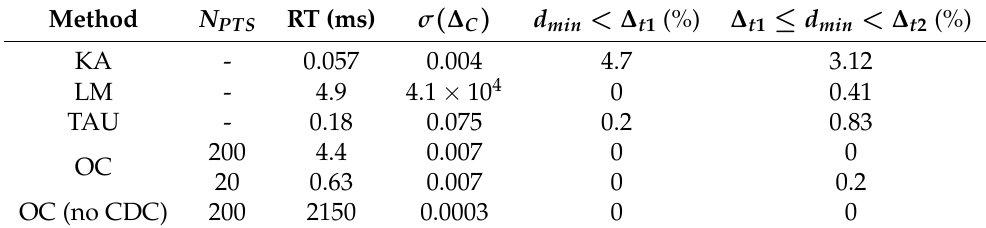
Table 3. Fitting results for case study 2.